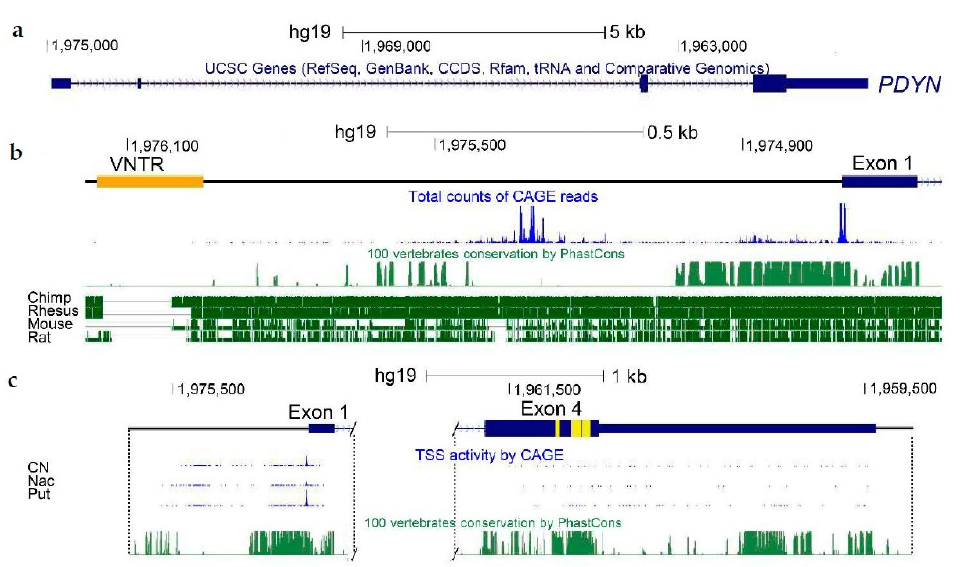
Figure 1. Human PDYN gene (modified screenshot from UCSC Genome Browser). ( a ) Gene structure. ( b ) Promoter PDYN region with VNTR and TSSs. Conservation across vertebrates. ( c ) Canonical PDYN mRNAs and transcripts initiated in exon 4. Their conservation across vertebrates. Non-coding sequences are shown by thin dark blue line; coding sequences by thick dark blue line; dynorphin peptides-encoding sequences by yellow . CN, caudate nucleus; NAc, nucleus accumbens; Put, putamen. Modified from [41].